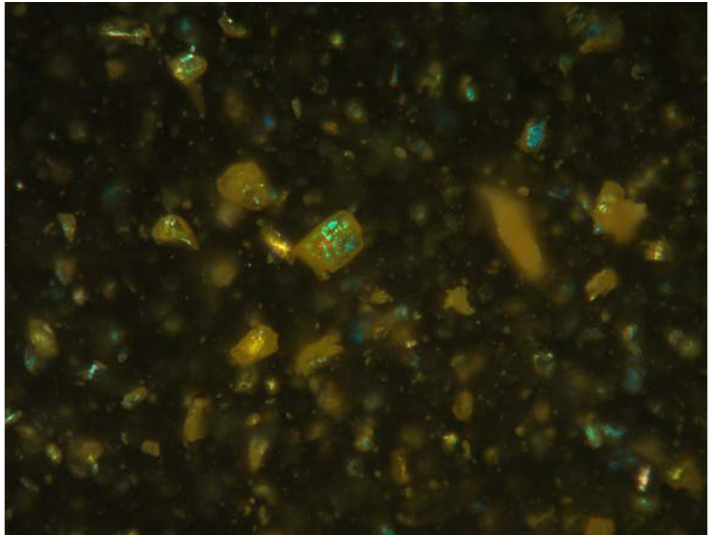
Figure 6. Natural realgar prepared as a pigment supplied by Kremer Pigmente and viewed in cross-polarised light (XPL). The image shows the typical anomalous green interference colours exhibited by this mineral; 400×, field of view is 0.25 mm. Photomicrograph by Ruth Siddall.